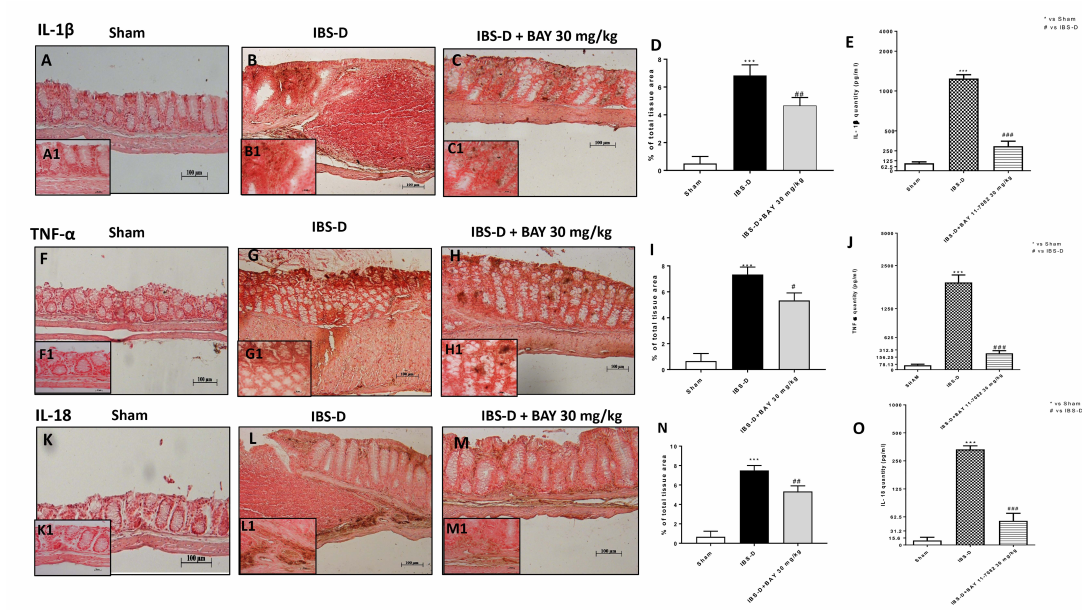
Figure 6. E ff ect of BAY 11-7082 treatment on IL-1 β , TNF- α , and IL-18 expression. By immunohistochemical analysis, an increase of IL-1 β , TNF- α , and IL-18 expression was found in the IBS-D group compared to the sham group (( A , B ); ( F , G ); ( K , L ) respectively); while the treatment BAY 30 mg / kg was able to significantly reduce their expressions (( C ), see histological score ( D ); ( H ), see histological score ( I ); ( M ), see histological score ( N )). ELISA kit confirmed the results ( F , J , O ). Data are representative of at least three independent experiments. ( D ) *** p < 0.001 vs. Sham. ## p < 0.01 vs. IBS-D. ( I ) *** p < 0.001 vs. Sham. # p < 0.05 vs. IBS-D. ( N ) *** p < 0.001 vs. Sham, ## p < 0.01 vs.